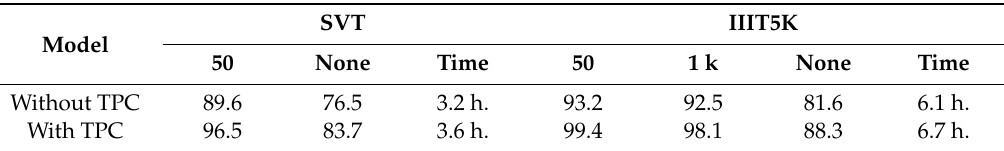
Table 4. TPC’s recognition accuracies (%) and its ablation study.